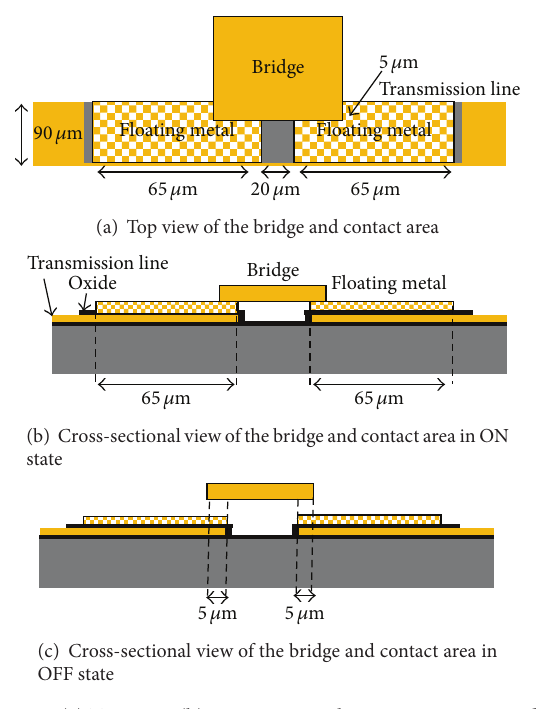
Figure 4: (a) Top view, (b) cross-sectional view in ON state, and (c) cross-sectional view in OFF state at the bridge and contact